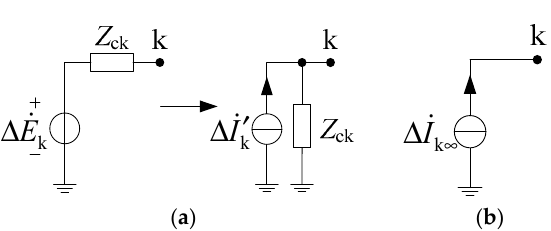
Figure 9. Equivalent circuit of AC fault-component of a VSC-based renewable energy: ( a ) transient period; ( b ) steady period.